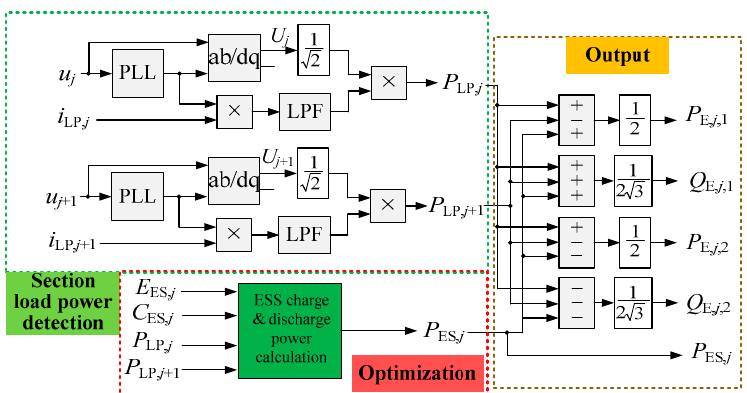
Figure 19. Detection block diagram in decentralized control of the EPTD.